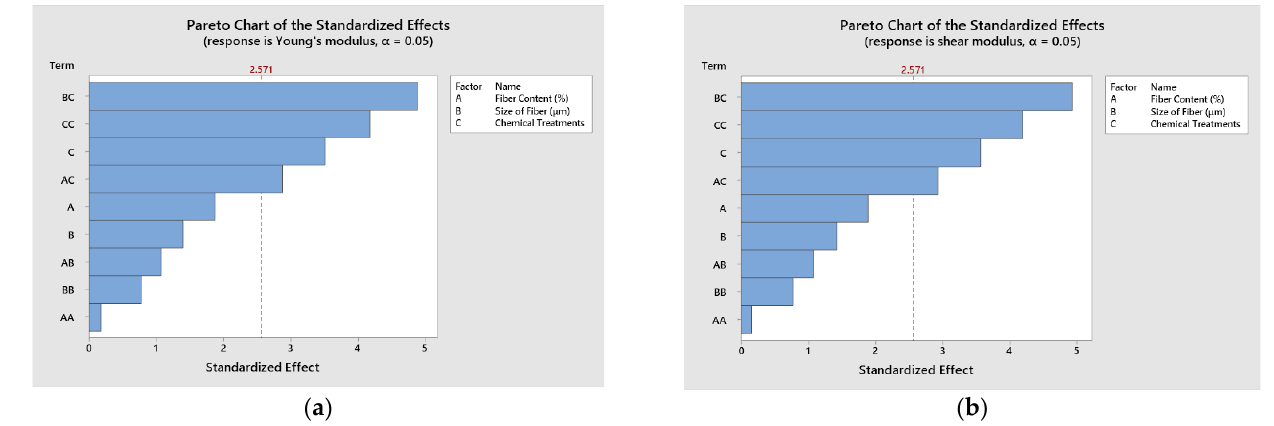
Figure 13. Pareto charts of the standardized effects on elastic constants. ( a ) Young’s modulus ( b ) shear modulus.